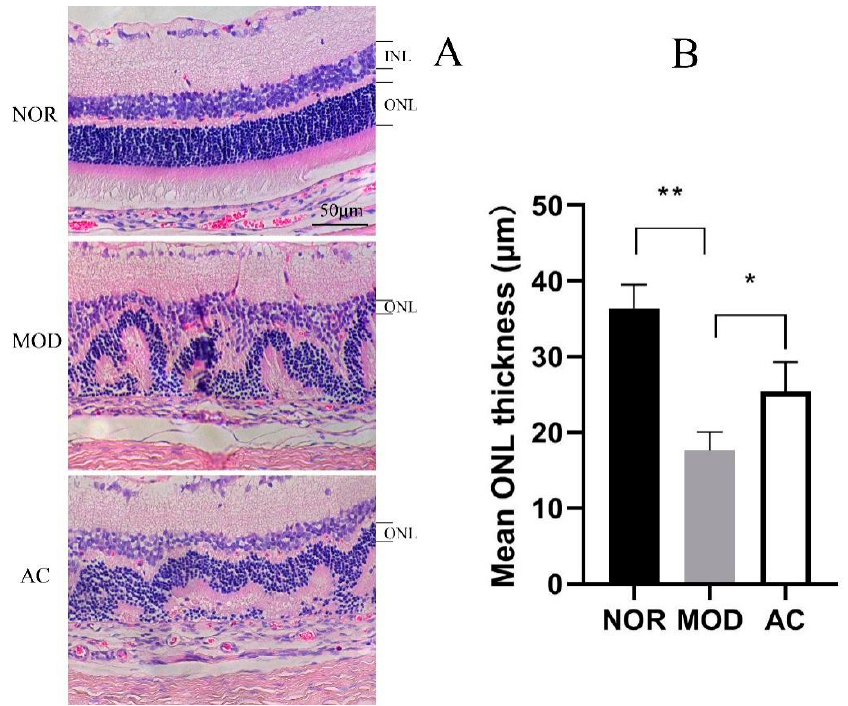
Figure 3. Effect of aronia fruit extract on the structure and outer nuclear layer (ONL) thickness of rat retina. ( A ) Images of the H&E stained sections of rat retinas, taken at 200× magnification. ( B ) Outer nuclear layer thickness of the retinas. Data are the mean ± standard deviations (n = 8). (*) p < 0.05, (**) p < 0.01 (one-way ANOVA followed by Tukey’s test).